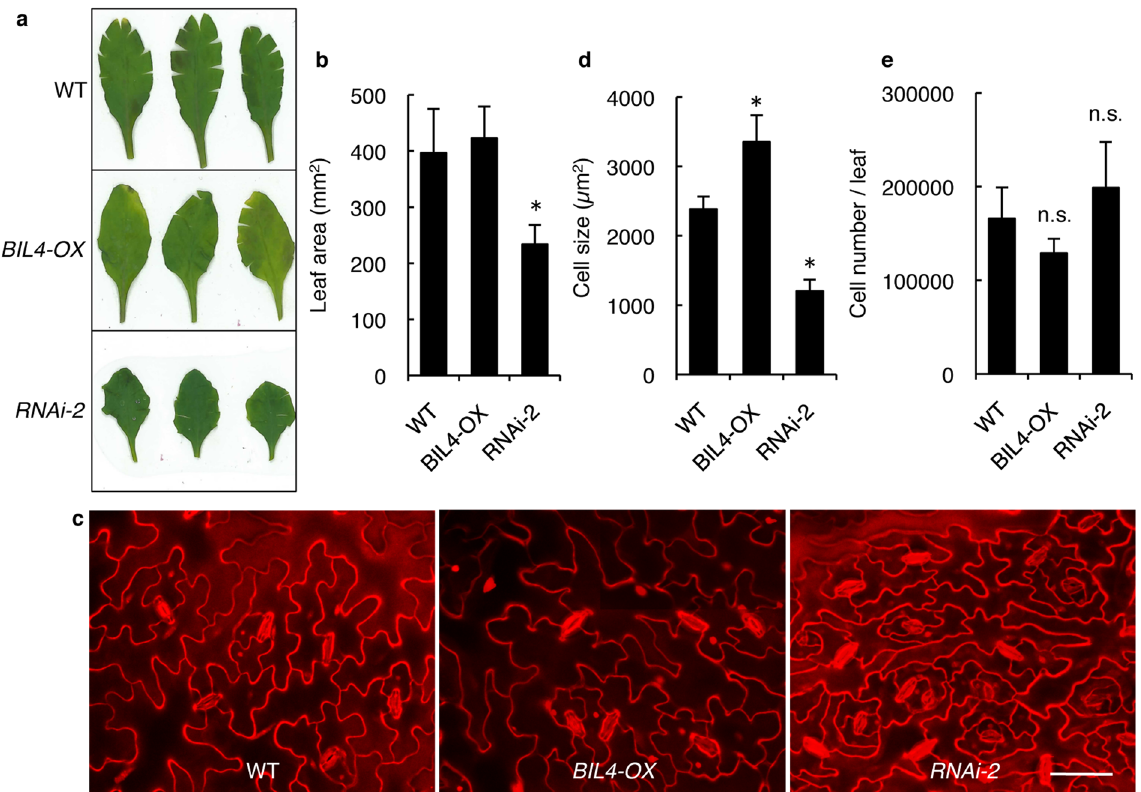
Figure 3. BIL4 positively affects the size of leaf epidermal cells. ( a ) Rosette leaves of wild-type, BIL4-OX and BIL4-RNAi-2 ( RNAi-2 ) plants 6 weeks after sowing. ( b ) Leaf area of wild-type, BIL4-OX and RNAi-2 plants. The results are presented as the mean ± s.d., n = 5 leaves. Asterisks indicate a significant difference from the wild-type plants ( P < 0.01 by Student’s t -test). ( c ) Confocal images of the epidermis of 6-week-old wild-type, BIL4-OX and RNAi-2 rosette leaves stained with PI. Scale bar, 50 μ m. ( d ) Cell size in the epidermis of wild-type, BIL4-OX and RNAi-2 rosette leaves. The results are presented as the mean ± s.d., n = 9 areas. Asterisks indicate a significant difference from the wild-type plant ( P < 0.01 by Student’s t -test). ( e ) Epidermal cell number of wild- type, BIL4-OX and RNAi-2 rosette leaves. The results are presented as the mean ± s.d., n = 5 leaves; n.s. indicates no significant difference from the wild-type plants (by Student’s t